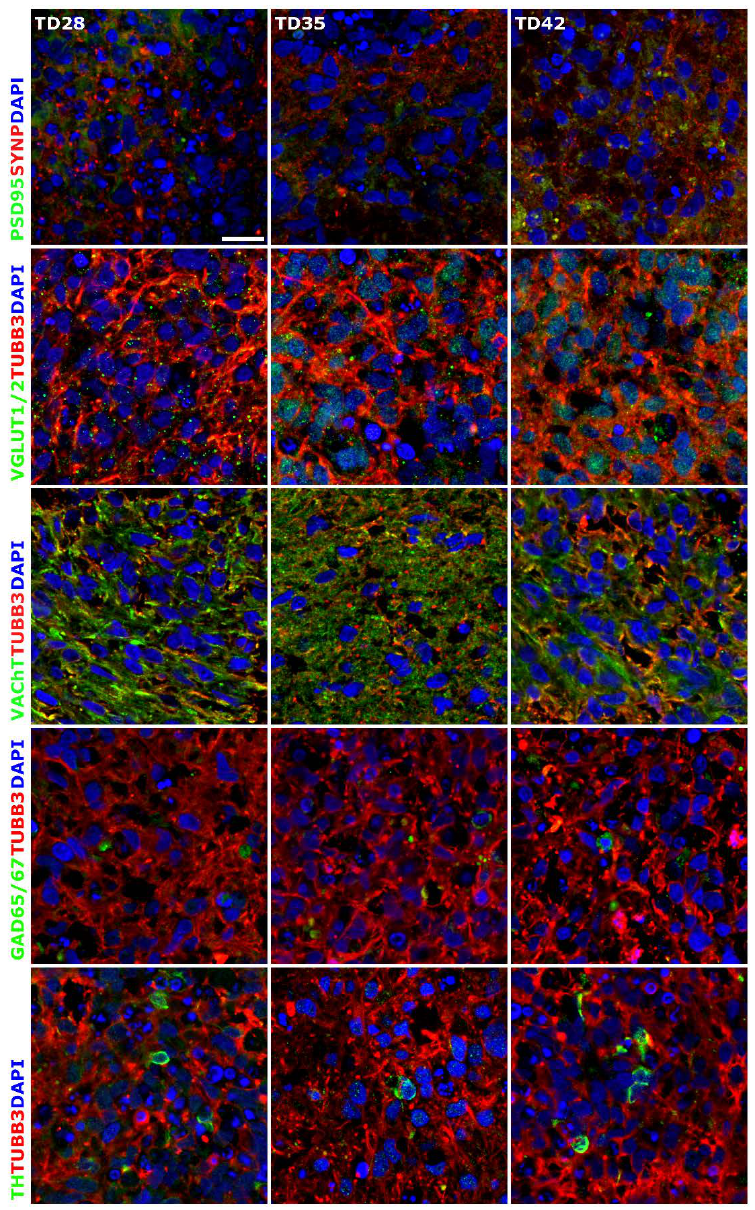
Figure 4. Immunocytochemical detection of neuronal subtypes in 3D neurospheres. Presence of synapses was determined with post-synaptic marker PSD95 and synaptic protein Synaptophysin (SYNP) double staining. Glutamatergic (VGLUT1/2), GABAergic (GAD65/67), cholinergic (VAChT) and dopaminergic (TH) neurons were detected in the developing 3D neurospheres from D28. All samples were stained with TUBB3 (in red) to label the neurites. Protein name IDs are indicated with colors, representing the color of the used fluorophore (e.g., green as Alexa 488; red as Alexa 594). Nuclei were counterstained with DAPI (in blue). Scale bar: 25 µm.